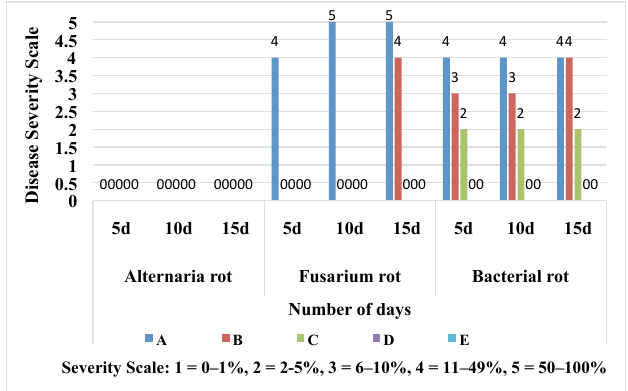
Fig. 3A: Effect of fluorescent Pseudomonas species on disease severity of tomato stored at 23±4 ºC with relative humidity in the range of 25-70% in season 2013. A = Control, B = 1% K-sorbate, C = HAB-10, D = HAB-25,